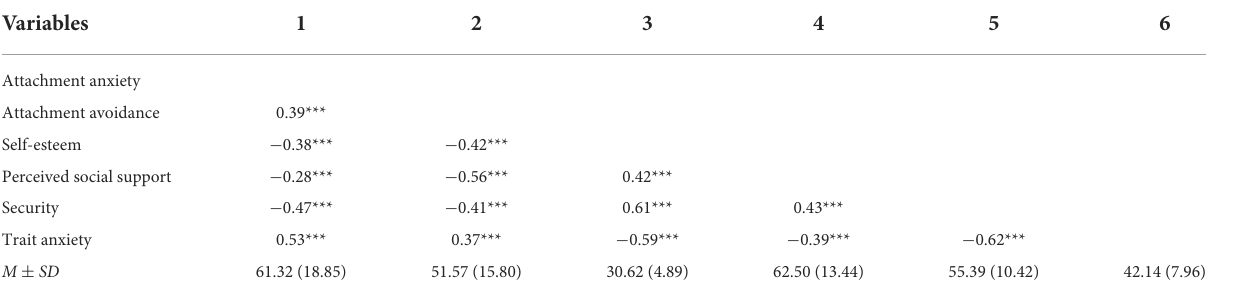
TABLE 1 Descriptive statistics and correlations among the variables.